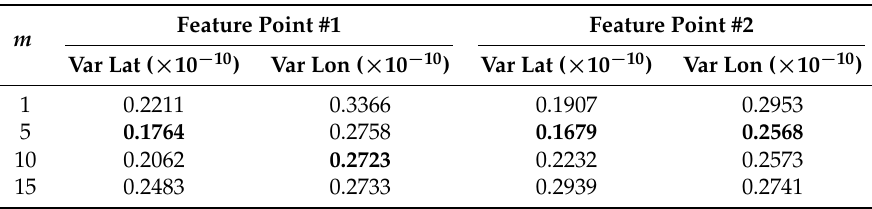
Table 1. A reconstructed location (latitude and longitude) variances of two feature points in Seq-1 using different numbers ( m ) of frame pairs. The smallest variance value in each column is highlighted with bold